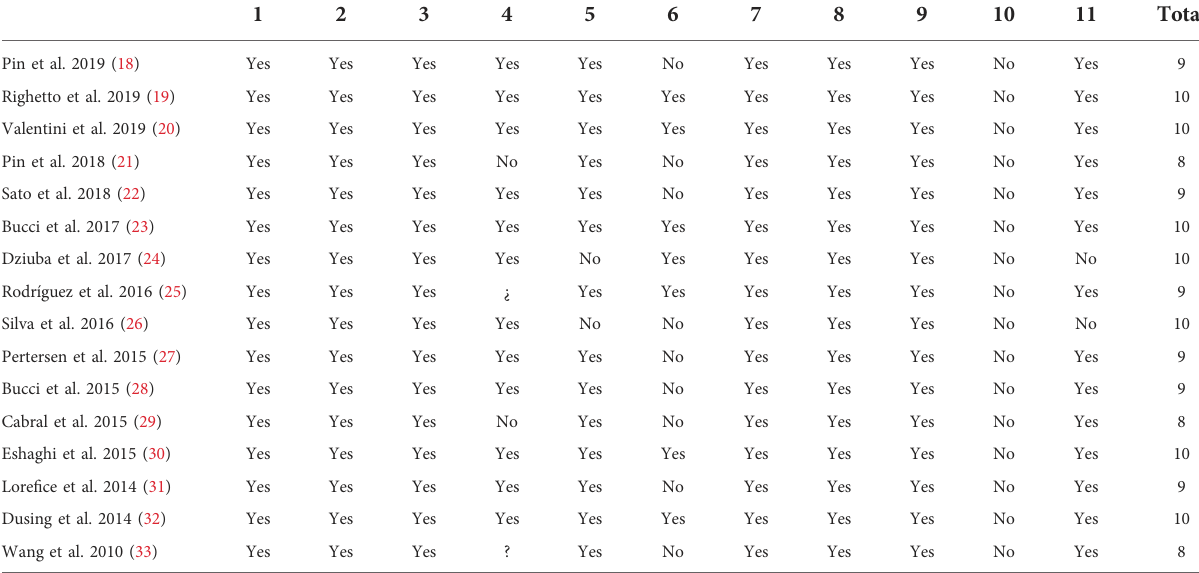
TABLE 2 Quality assessment: case-control critical Reading programme CASPe.